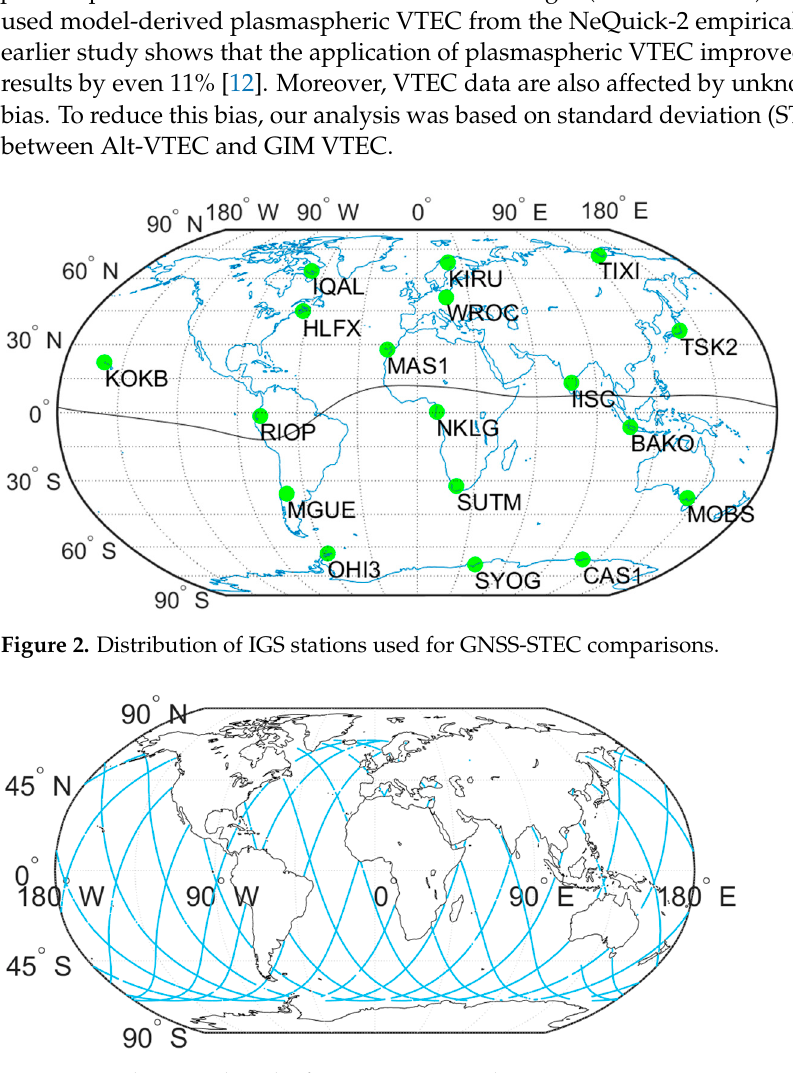
Figure 2. Distribution of IGS stations used for GNSS-STEC comparisons.